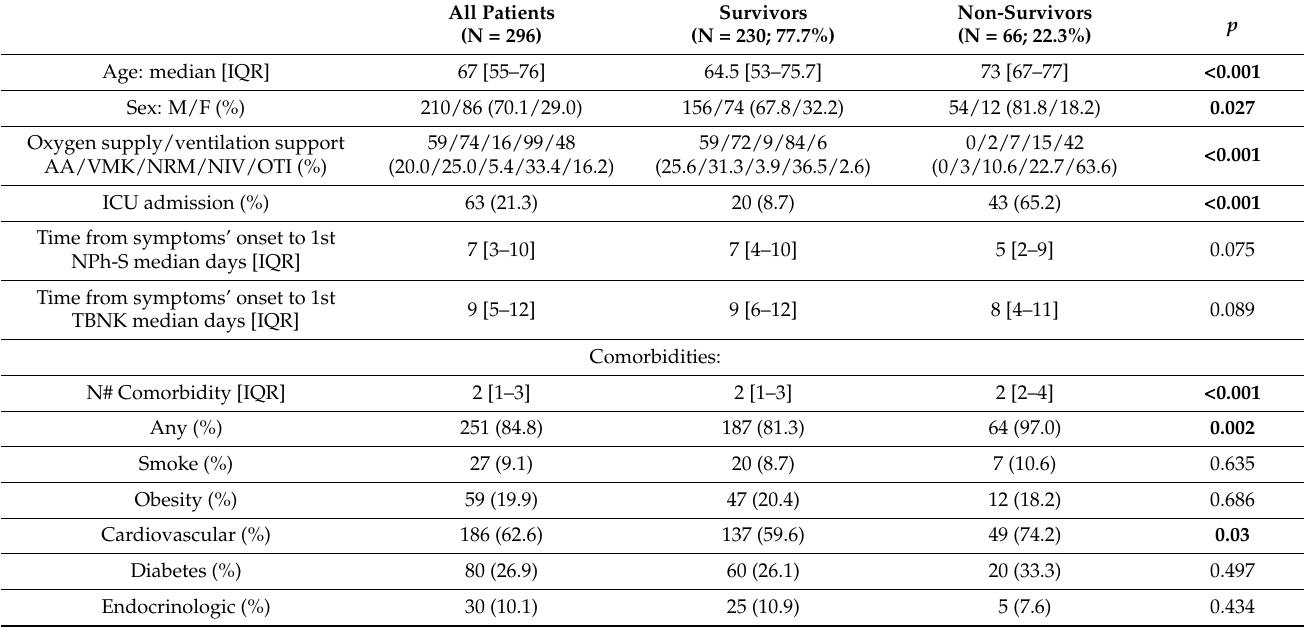
Table 1. Demographic and clinical characteristics of the study cohort, overall and after stratification for outcome (survivors and